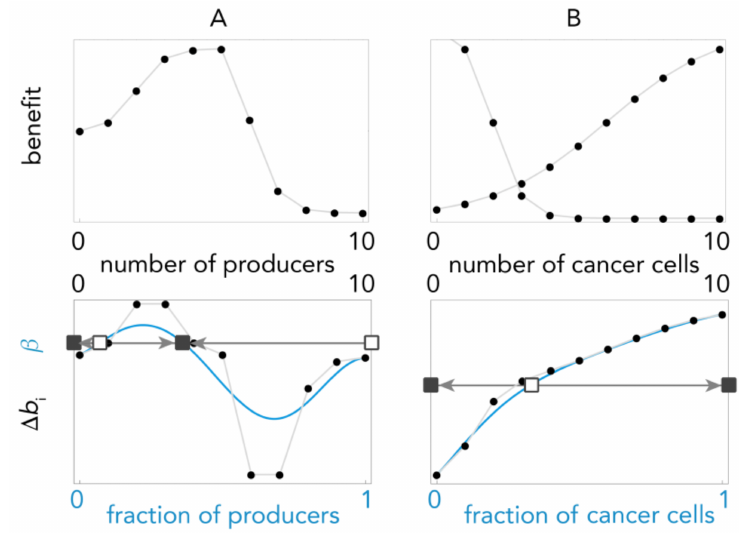
Figure 4. The gradient of selection β (continuous blue line) and its Bernstein coefficient ∆ b i (dotted line) for more complex functions; squares show the equilibria (full: stable; empty: unstable); arrows show the direction of the dynamics (determined by the sign of the gradient of selection); A: The double inverse sigmoid function described in (13) ( n = 10, h 1 = 0.4, h 2 = 0.2, s 1 = 10, s 2 = 10, c = 0.1, y = 2, d = 0.5). B: Two different benefit functions described by (16) and (17) ( n = 10, h 1 = 0.6, h 2 = 0.2, s 1 = 5, s 2 = 20, c =